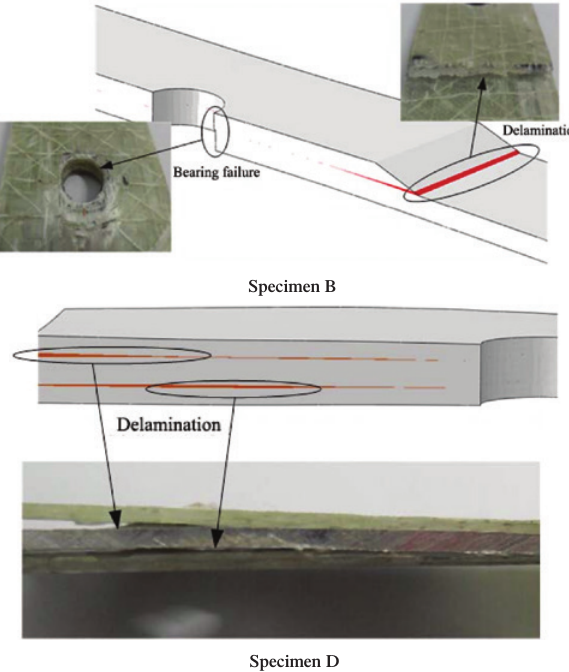
Figure 11: The comparison of delamination failure mode between experimental results and